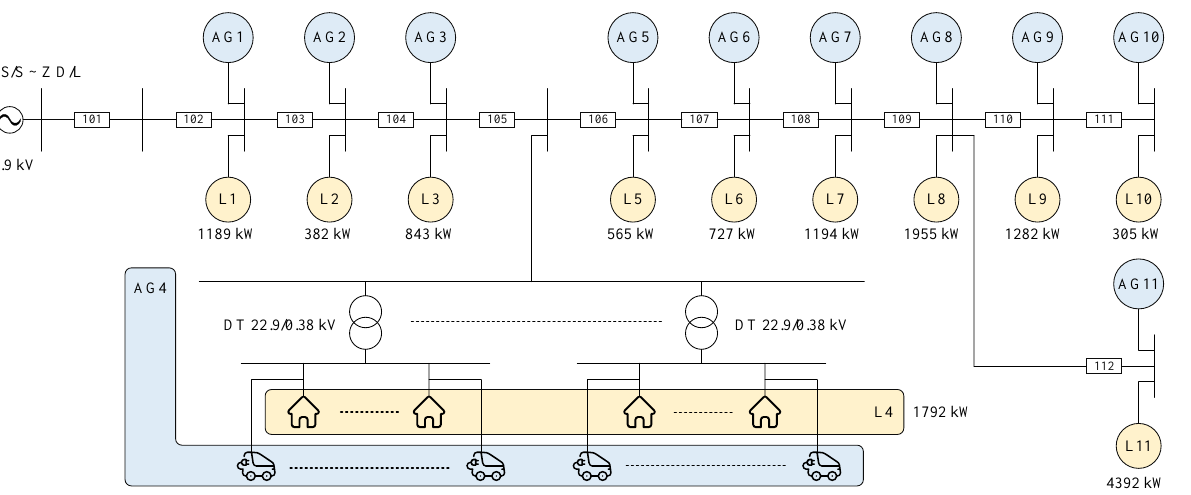
Figure 4. KEPCO X S/S—Z D/L feeder configuration.